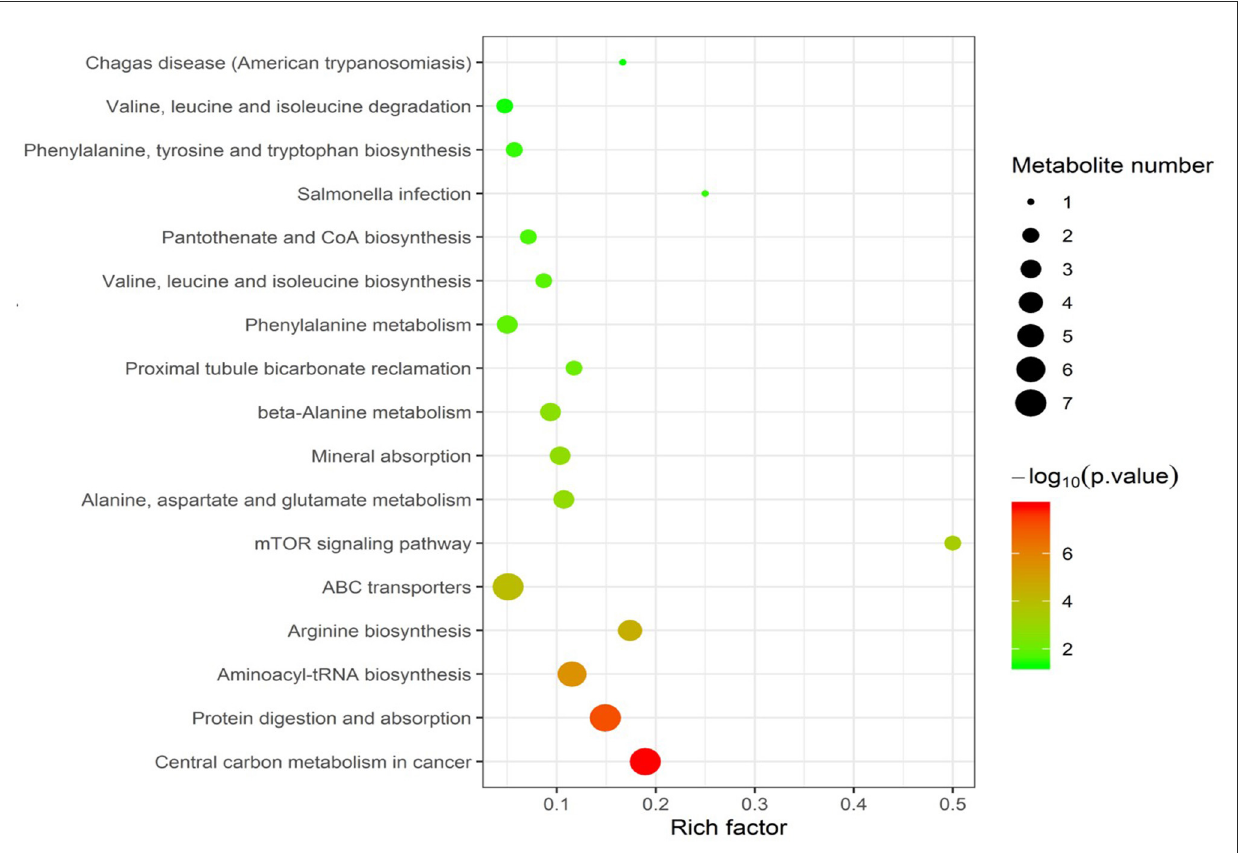
FIGURE4 Kyoto Encyclopedia of Genes and Genomes enrichment of differential metabolites.